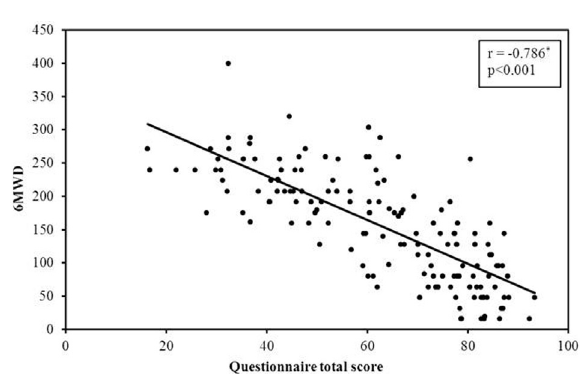
Correlation between 6 minute walk distance and St George ’ s Respi- ratory